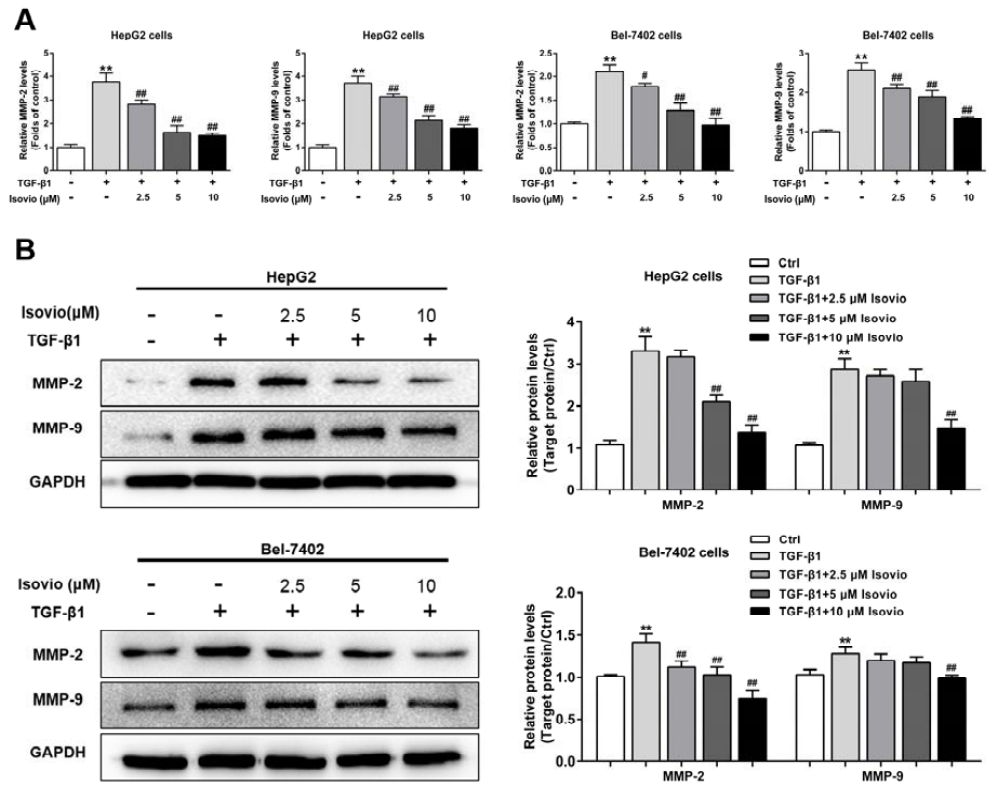
Figure 4. Effects of isoviolanthin on TGF- β 1-induced matrix metalloproteinase (MMP)-2 and -9 in HCC cells. ( A ) HepG2 and Bel-7402 cells were treated with 10 ng/mL TGF- β 1 for 48 h, during which isoviolanthin (2.5 µ M, 5 µ M, and 10 µ M) was added for the last 24 h. The secretion of MMP-2 and -9 in HCC cell supernatants was detected by ELISA; ( B ) The protein levels of MMP-2 and -9 in HCC cells were examined by Western blot analysis. GAPDH was used as a loading control. Representative images and bar graphs (mean ± SD) are shown, n = 3. ** p < 0.01 versus the control group; # p < 0.05, ## p < 0.01 versus the TGF- β 1